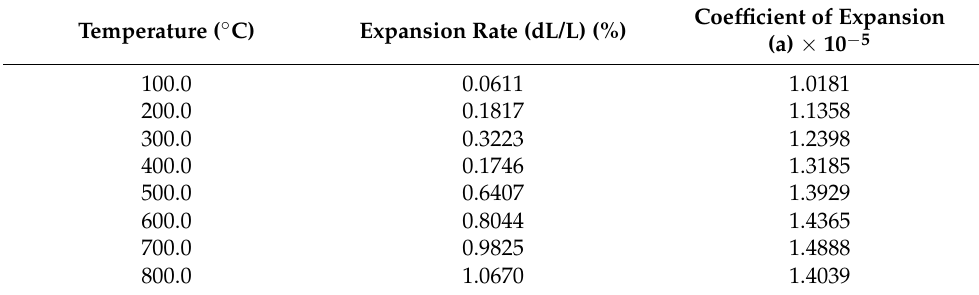
Table 4. Reinforcing bar thermal expansion